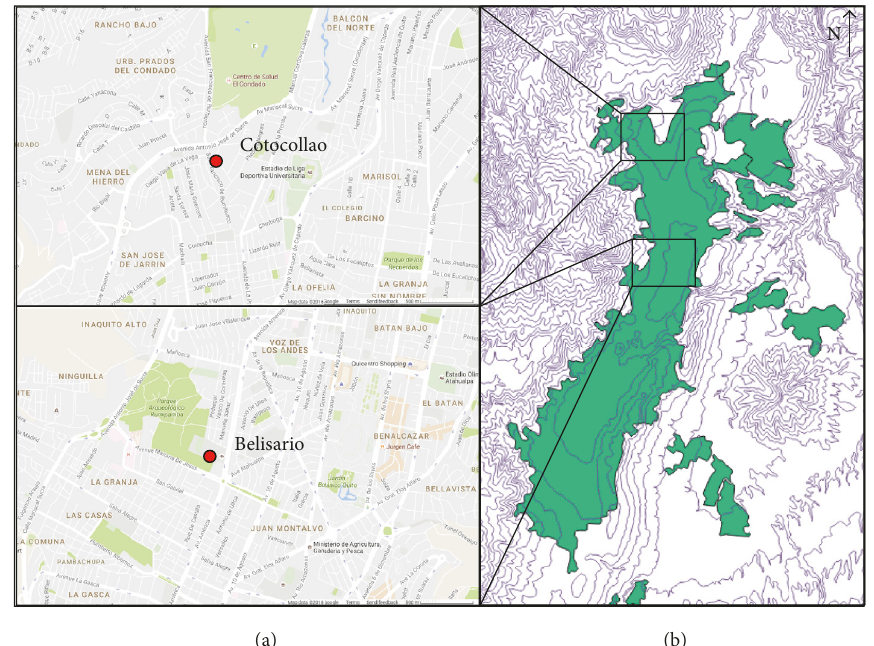
Figure 1: Topographic map (b) of Quito’s urban area (green areas) and Google maps images (a) of the air quality measurement sites (red dots) Cotocollao and